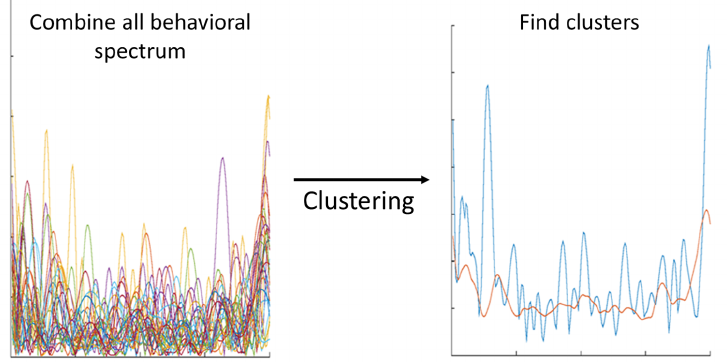
Figure 3. Example of the methodology used to identify habits from behavioral spectrum